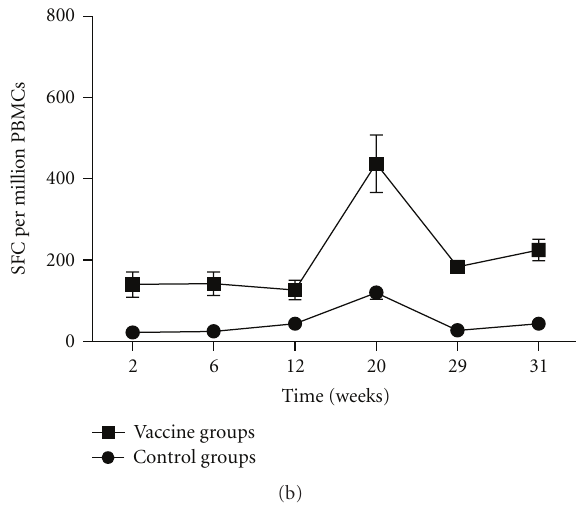
Figure 3: Number of IFN- γ -secreting PBMC was detected by ELISPOT after stimulation with p24 peptide pools at various times after immunization and challenge. (a) Histogram bars represent the average number of spots per million cells detected in duplicate cultures for each animal, after subtraction of the average number of spots found in duplicate control cultures of PBMC without stimulation. (b) Dynamics of the IFN- γ response was observed throughout the experiment for each